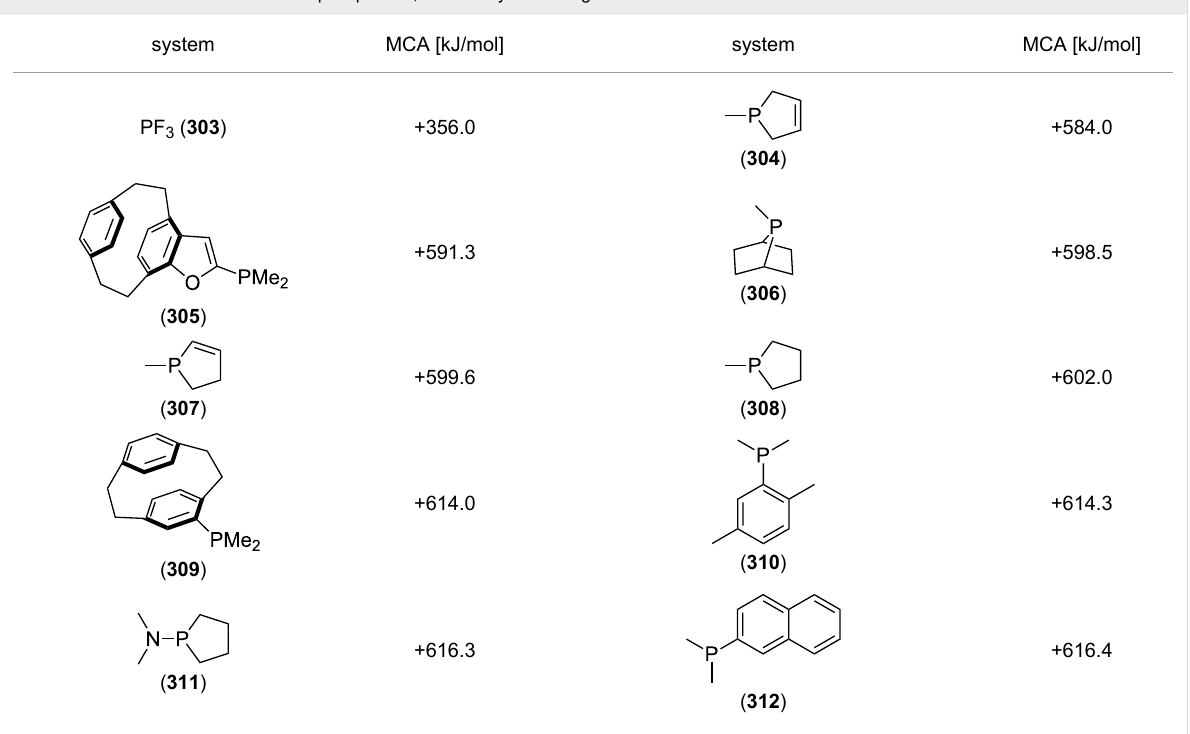
Table 7: MCA values of miscellaneous phosphanes, ordered by increasing MCA